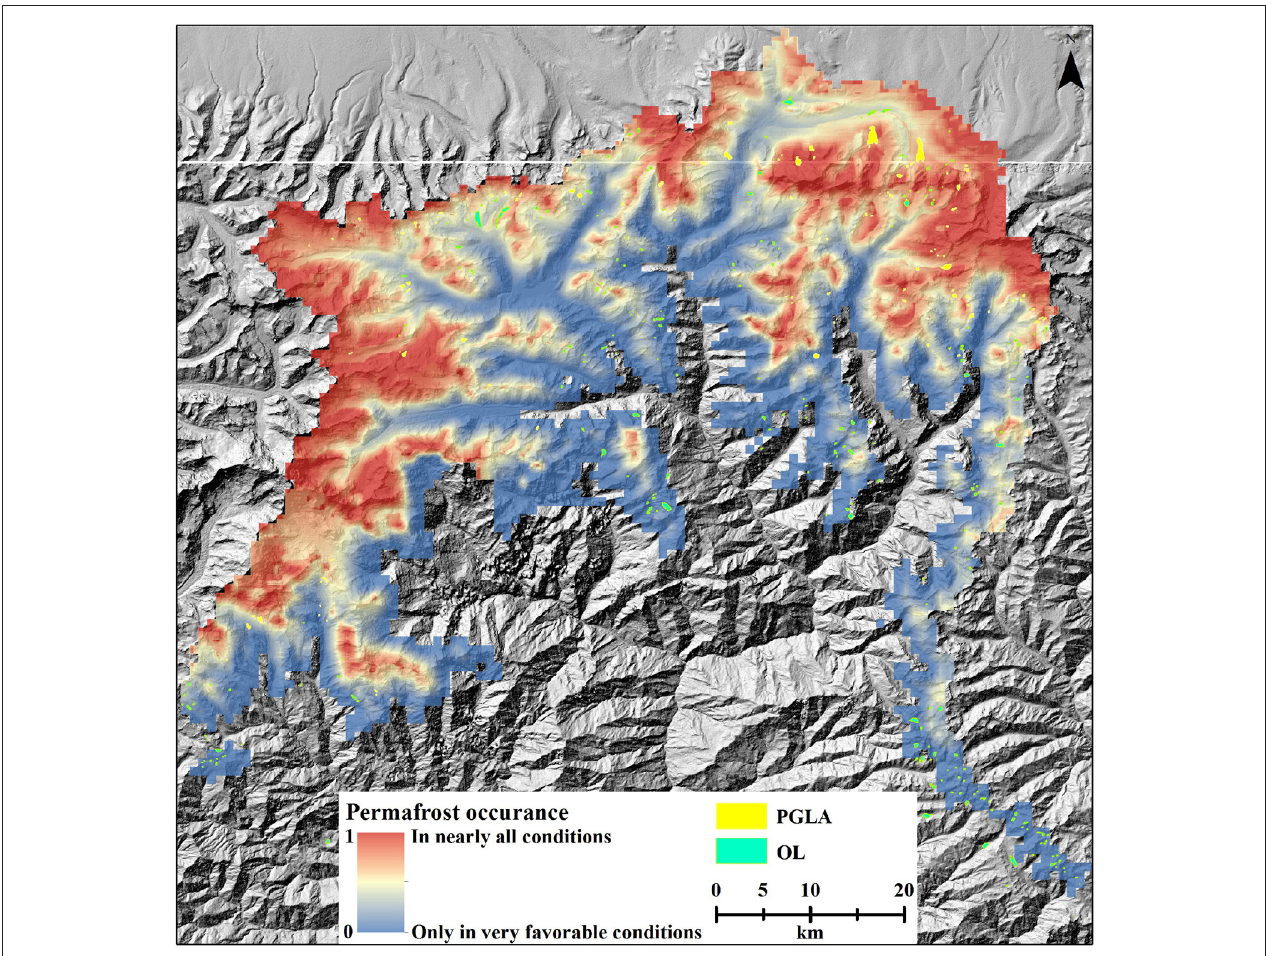
FIGURE 8 | Occurrence of permafrost in the state as shown by Permafrost Zonation Index (PZI) and distribution of peri/pro glacial lakes away from glaciers (PGLA) and other lakes (OLs) (Data source of PZI: Gruber, 2012).